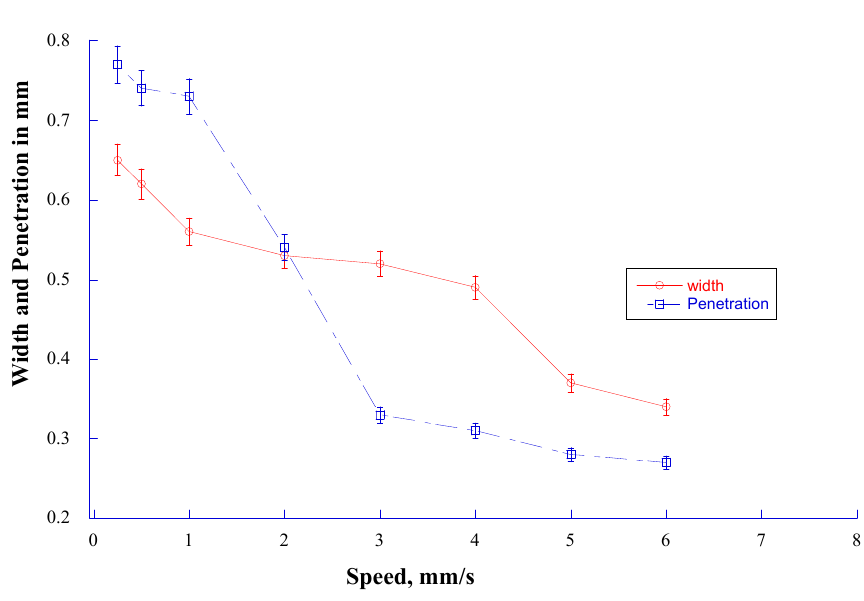
Figure 4. Influence of laser speed on the weld width and penetration.